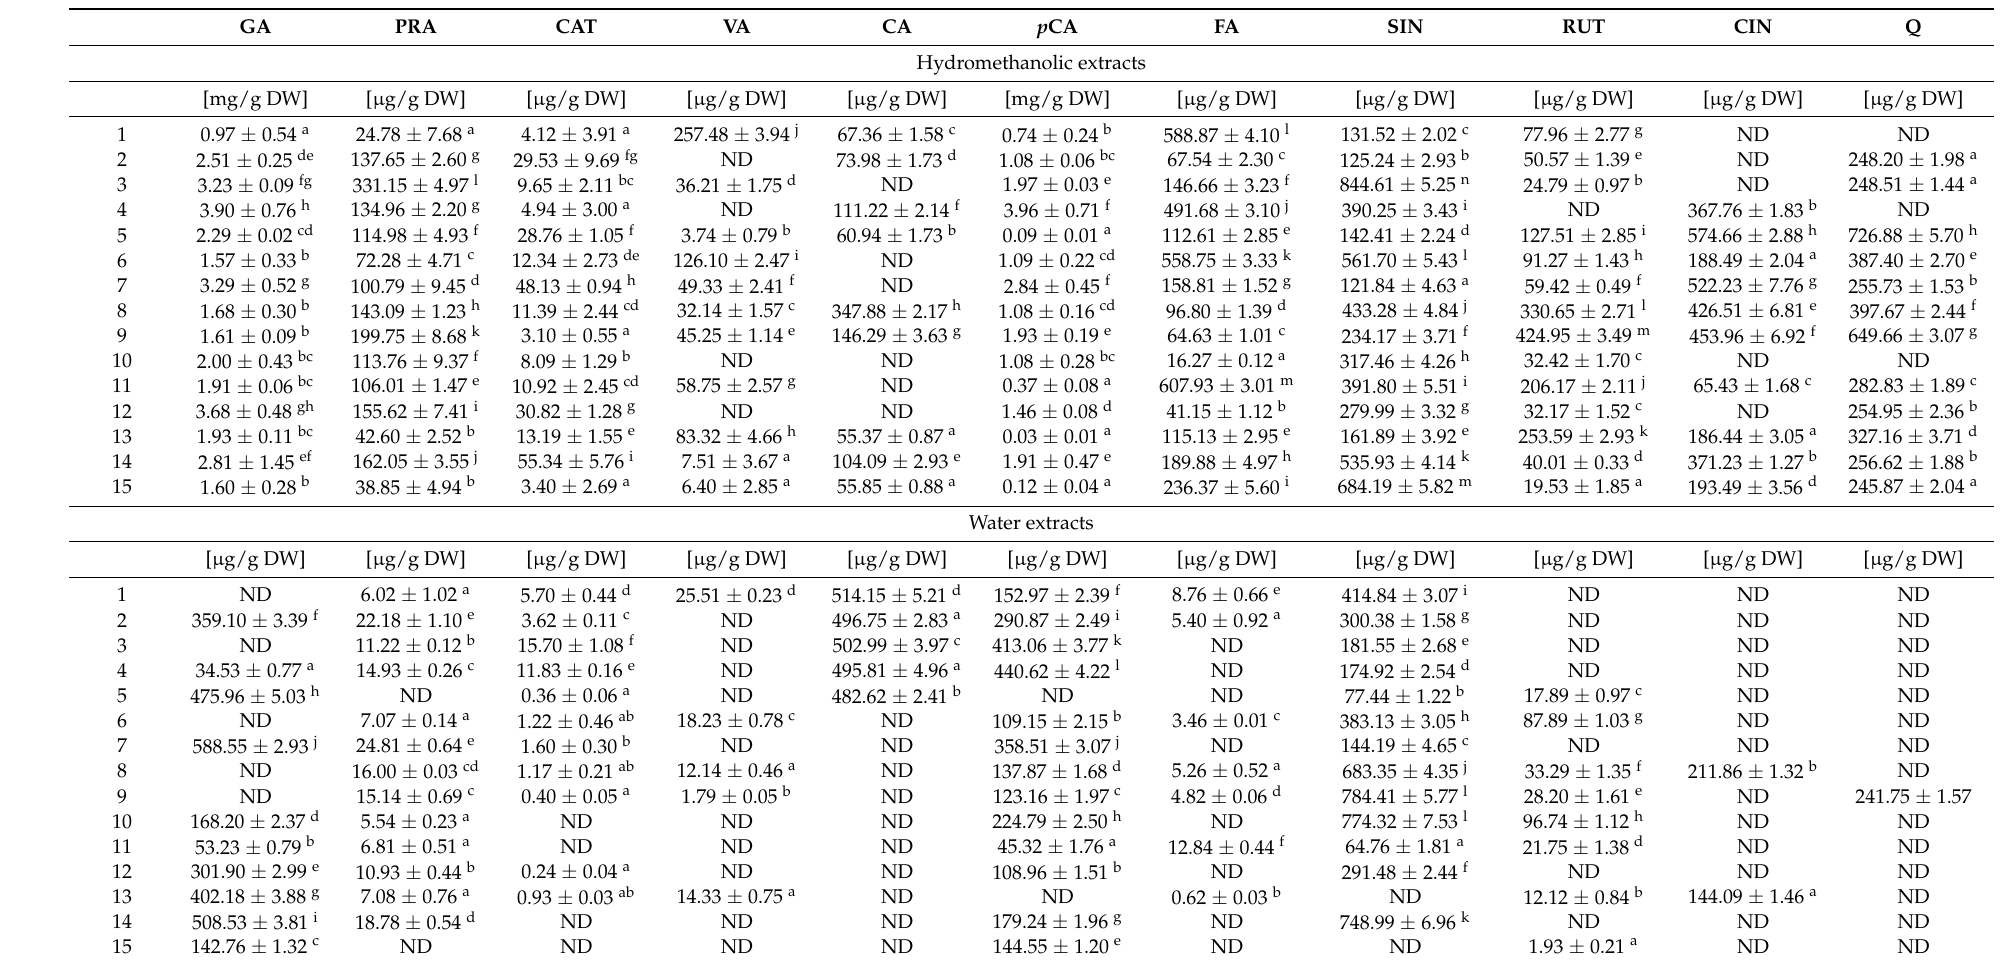
Table 3. The results of individual phenolic compounds in R. rosea commercial